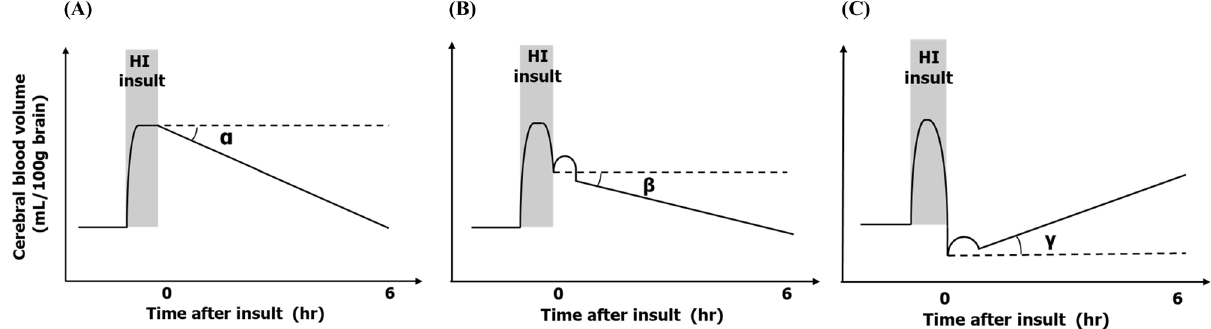
Figure 4. Schematic representation of the three types of changes in CBV during HI insult and after insult according to severity of insult. ( A ) In mild insults, CBV falls slightly during the insult and decreases to baseline after resuscitation. ( B ) In moderately severe insults, CBV decreases during the insult above the baseline and decreases after resuscitation to a smaller extent than in ( A ). ( C ) In severe insults, CBV falls during the insult to below the baseline and increases after resuscitation. The angles of the CBV changes from the basal horizontal line after resuscitation are α < β < γ (the angle values of α and β are negative, whereas that of γ is